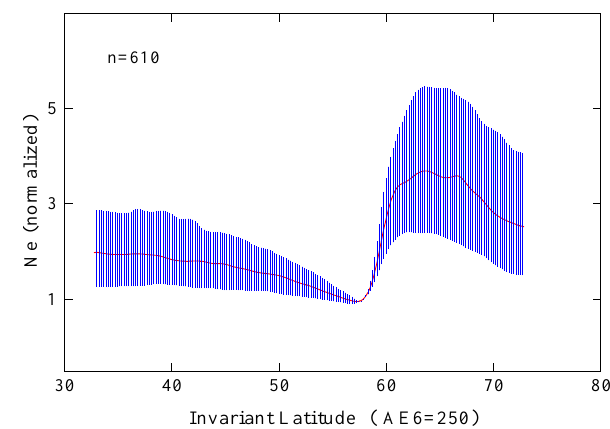
Fig. 10. Mean latitudinal profile of the polar cliff. The median of 610 density profiles is plotted (red curve). These profiles have been superimposed in such a way that the latitude of the foot of the po- lar cliff latf serves as a common reference location. In addition, all density values of a profile have been normalized to the respective density value Nef observed at this location. The blue-shaded area indicates the range between the upper and lower quartiles. The lati- tudes given on the abscissa apply to a geomagnetic activity level of AE6=250nT. For other activity conditions the mean profile should be shifted to higher or lower latitudes, in accord with the results presented in Fig. 3 and Eq.